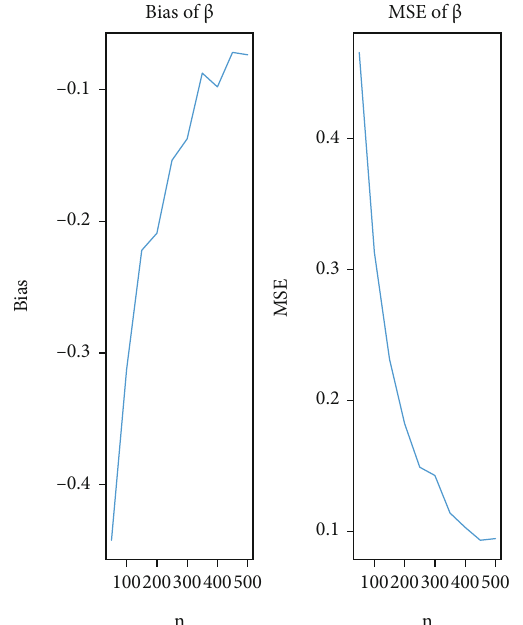
Figure 4: Biases and MSEs for the parameter β .